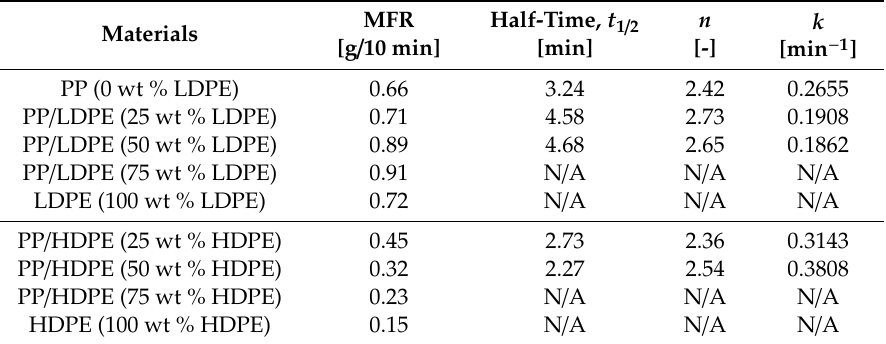
Table 1. Avrami index ( n ), overall crystallization rate constant ( k ), and crystallization half-time obtained during isothermal crystallization of PP, LDPE, HDPE and their blend at isothermal crystallization temperatures (125 ◦ C) at the cooling rate of 25 K / min.